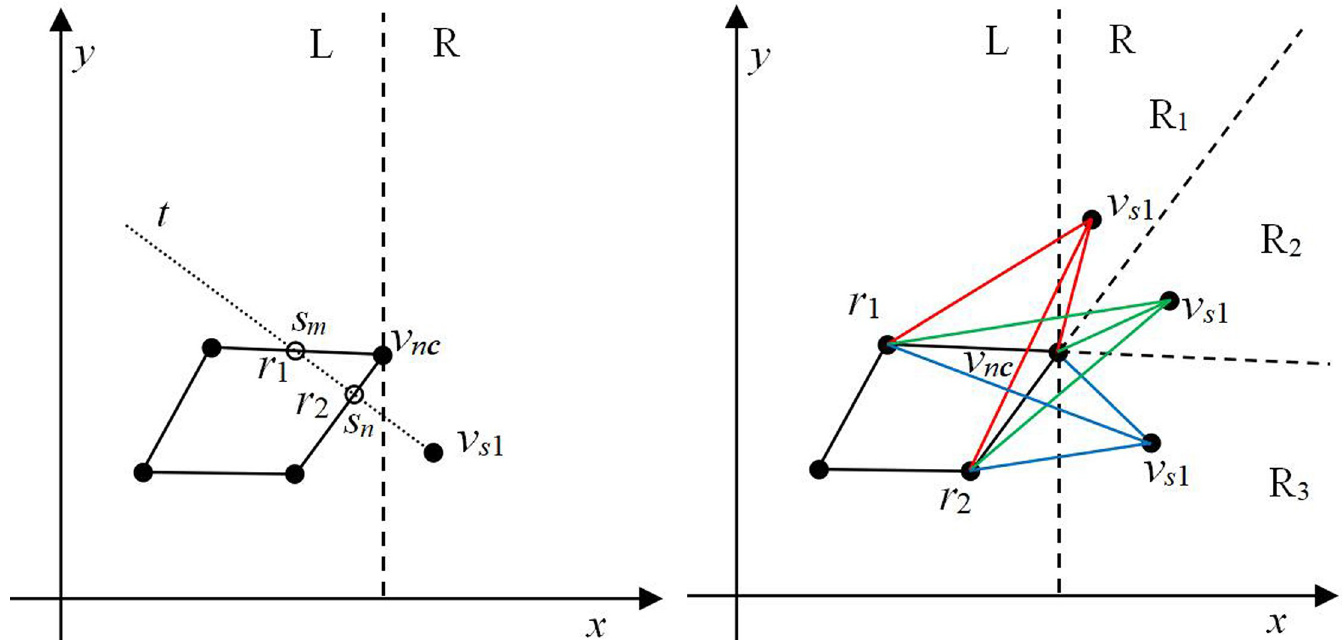
Fig 7. Example of line-to-point visibility. (a) Visibility example and (b) visibility from different regions.